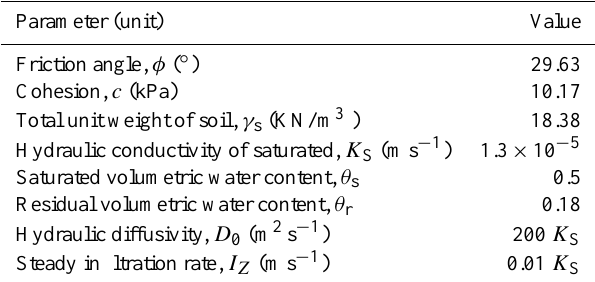
Table 2. Summary of values used in